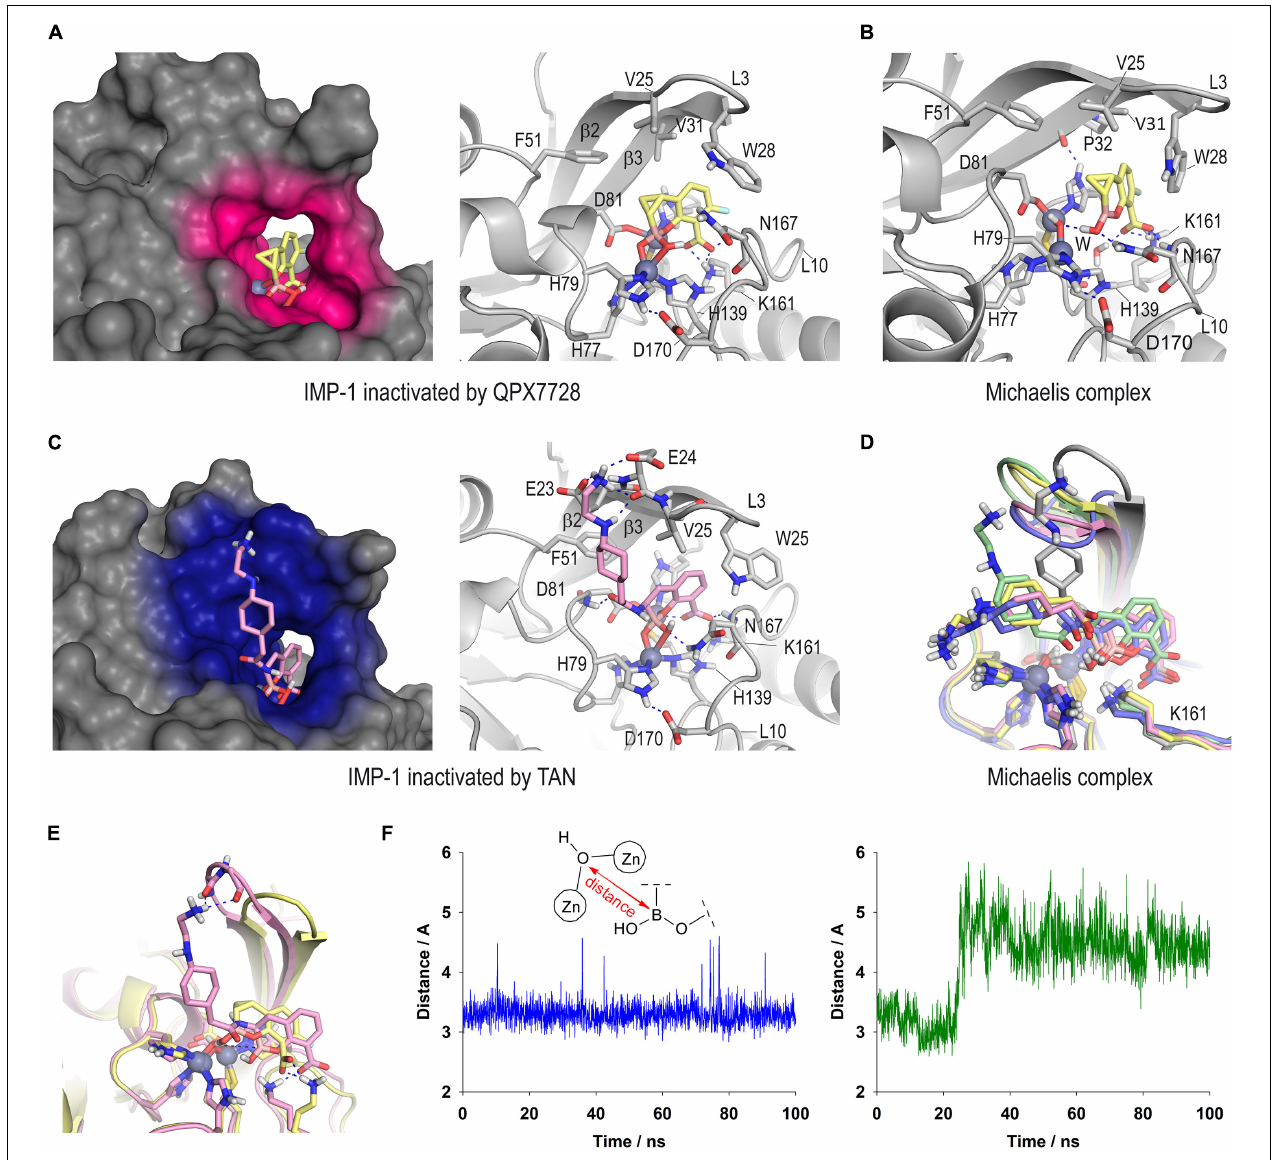
FIGURE 8 | Proposed three-dimensional structure of IMP-1 inactivated by QPX7728 (A) and taniborbactam (C) . Detailed and overall views are shown. The enzyme area in close contact with the modified inhibitor is highlighted in pink and blue colors, respectively. Snapshots after 80 ns of simulation are shown. Relevant side chain residues are shown and labeled. Zn(II) ions are shown as spheres. (B) QPX7728@IMP-1 Michaelis complex (snapshot @80 ns). (D) Superposition of several snapshots [20 ns (gray), 40 ns (yellow), 60 ns (pink), 80 ns (green), 100 ns (blue)] from the 100 ns of simulation on taniborbactam@IMP-1 Michaelis complex.